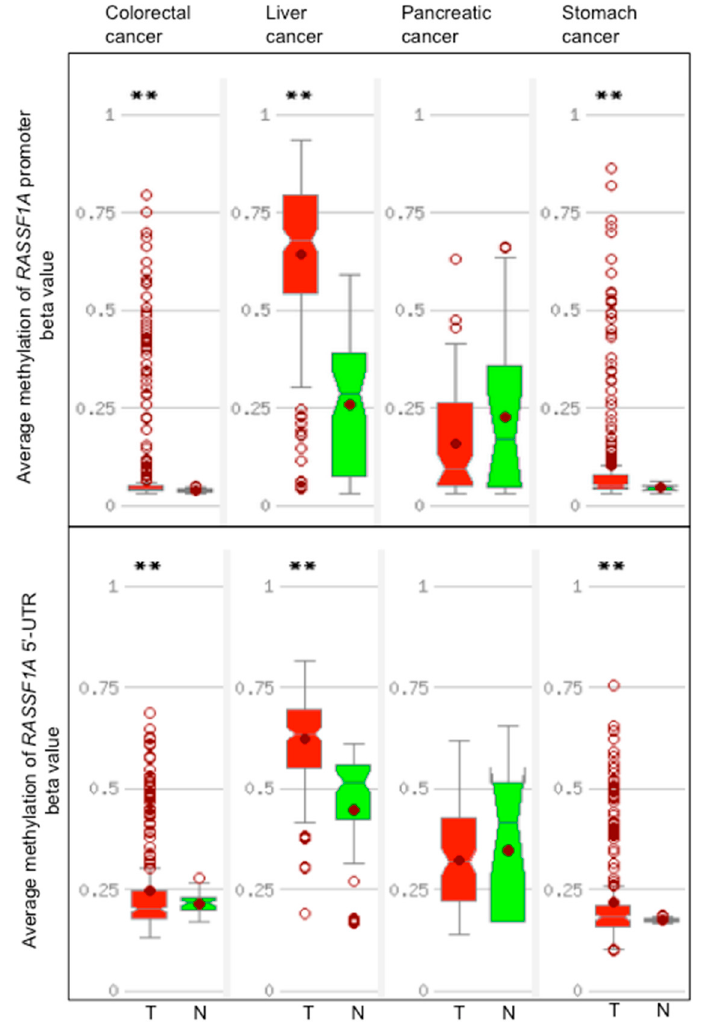
Figure 3. DNA methylation of the promoter and 5 ′ -UTR of RASSF1A in colorectal, liver, pancreatic, and stomach cancers and in the corresponding normal tissues. Distribution of average methylation in the promoter and 5 ′ -UTR of RASSF1A (NM_007182) in colorectal, liver, pancreatic, and stomach cancers cases. T, tumor tissues (red), N, normal tissue (green). 5 ′ -UTR is the 5 ′ untranslated region of the first exon of RASSF1A . The promoter region is defined as from 1.5 kb upstream to 0.5 kb downstream of the RASSF1A transcription start site. The graphs show the distribution of beta values calculated as methylated probe intensity divided the unmethylated probe intensity plus methylated probe intensity, plus 100. In the boxes, a horizontal line represents the median and the filled circle the average; the box represents the 25th percentile interval and the whiskers the 95th percentile interval of the distribution. Empty points represent outliers. The double asterisk indicates a significant di ff erence between T and N samples ( p < 0.005) calculated by the t -test. The graphs, retrieved from the MethHC site [114], are based on The Cancer Genome Atlas (TCGA)